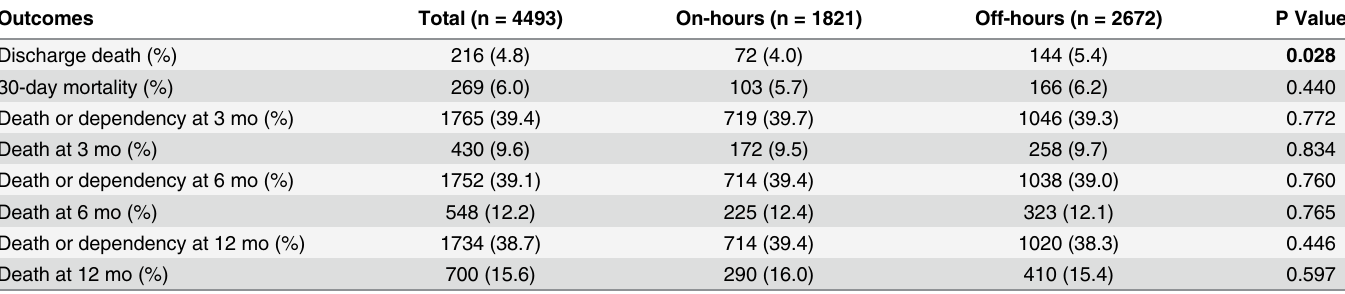
Table 3. Comparison of Patient Outcomes between On-hour and Off-hour Presentations after Ischemic Stroke.